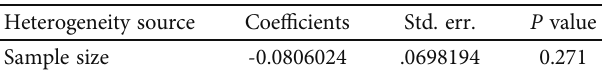
Figure 4: Subgroup analysis of mother ’ s care-seeking behavior for common childhood illnesses in Ethiopia by place of residence. Table 2: Metaregression analysis of factors a ff ecting between-study heterogeneity.